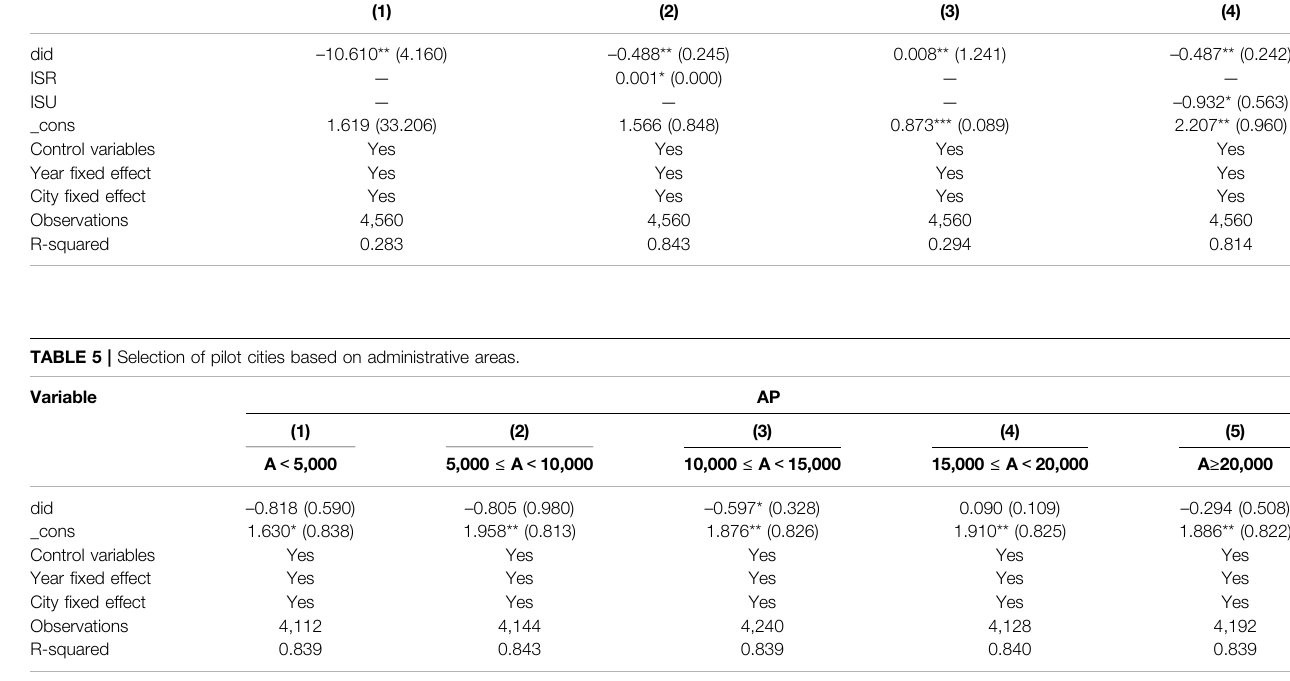
TABLE 4 | Impact mechanism of NIRDZs policy. Variable